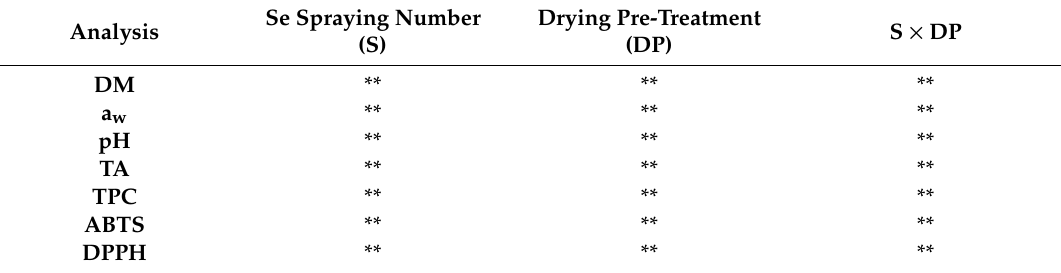
Table 7. Multivariate statistical analysis of treated